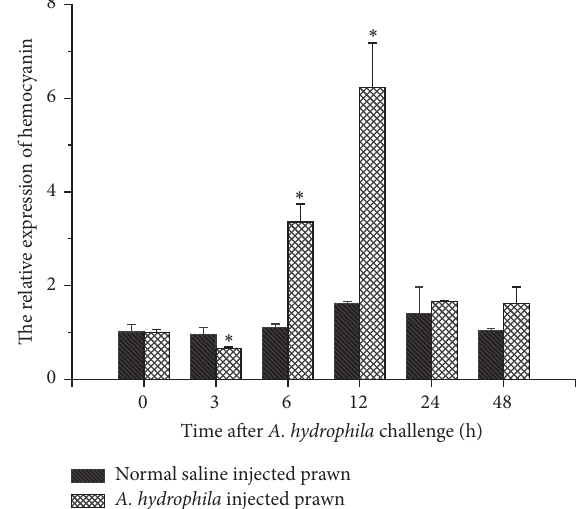
Figure 4: The hemocyanin gene expression in hemocytes of M. nip- ponense . The statistical test was performed by 𝑡 -test after challenge with A. hydrophila compared to the control at the same time points (0, 3, 6, 12, 24, and 48 h). The internal standard was 𝛽 -actin gene. Asterisks indicate being significantly different ( 𝑃 < 0.05 ).